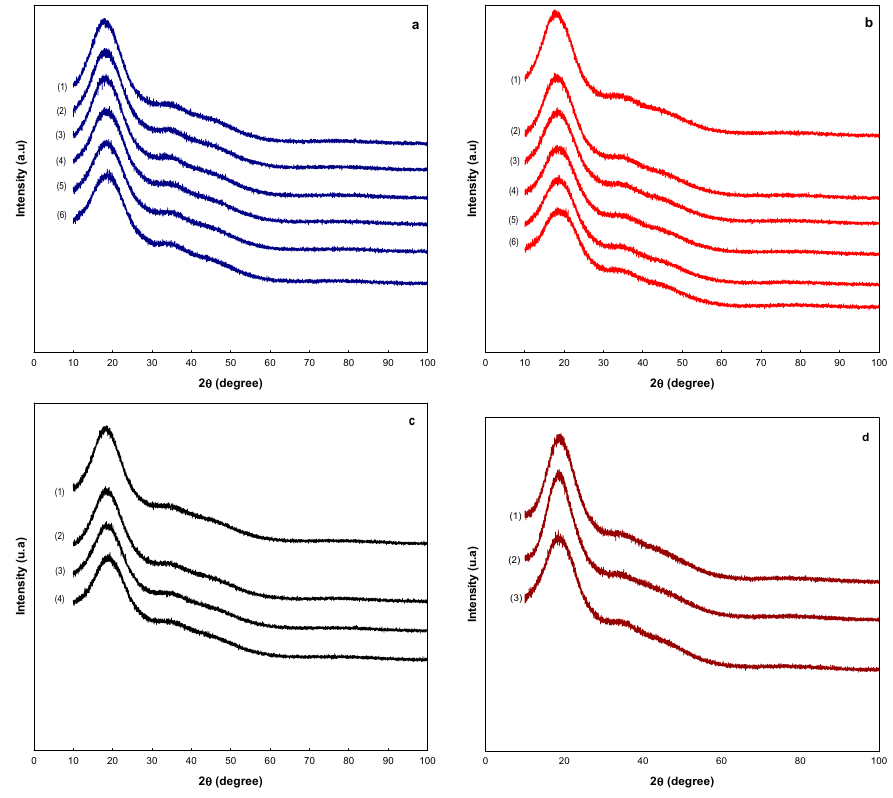
Figure 5. Analysis of the microstructure of the MXs by XRD: ( a ) Mc; ( b ) M10; ( c ) M20; and ( d ) M40. Water activities are indicated by the numbers: (1) 0.070, (2) 0.328, (3) 0.434, (4) 0.532, (5) 0.718, and (6) 0.75.